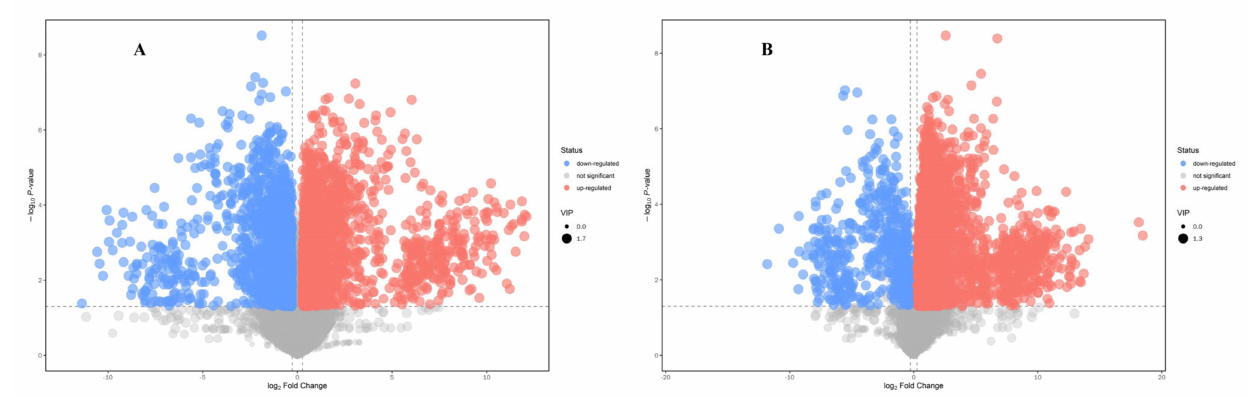
Figure 3. Volcano plot for the FLL vs. the LL. ( A ) Positive-ion mode; ( B ) Negative-ion mode. Gray indicates that there is no significant difference, red means significantly up-regulated, blue indicates significant down-regulation.